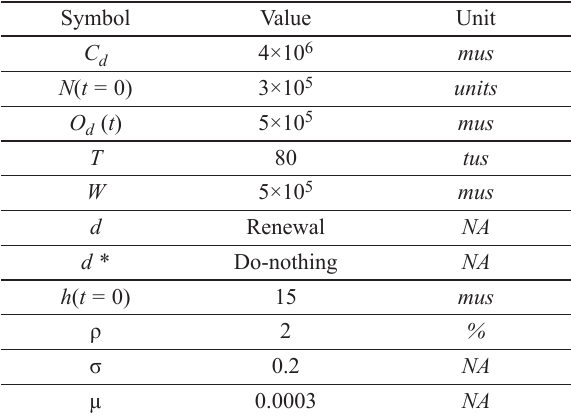
Table 3. Model’s input parameters